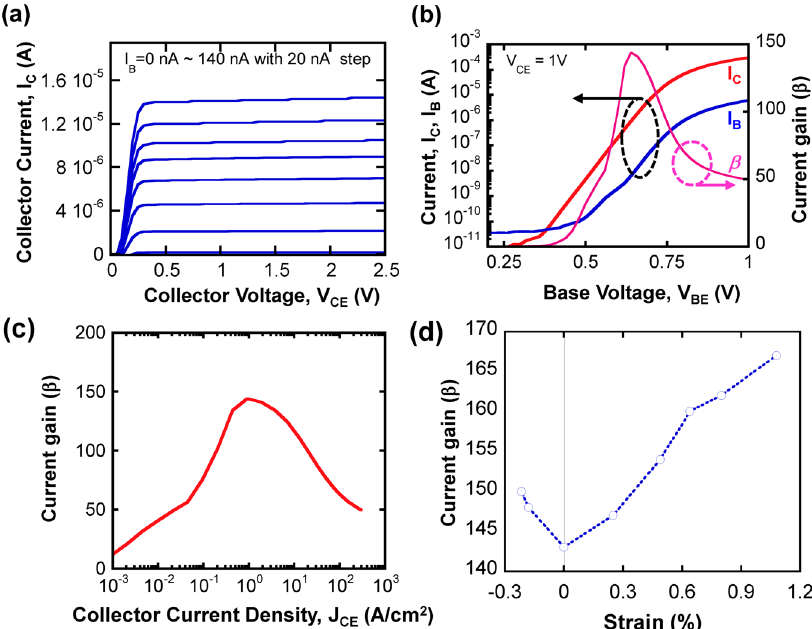
Fig. 6 Device characteristics of NPN BJT a Collector current ( I CE ) – voltage ( V CE ) of the NPN BJTs with different base current ( I B ) from 40 to 140 nA with 20 nA increments. b Gummel plot and current gain ( β ) plot showing a maximum DC gain of 143 at V CE of 1 V. c Current gain ( β ) as a function of the collector current density. d Changes in current gain ( β ) under bending conditions up to 1.08 % of